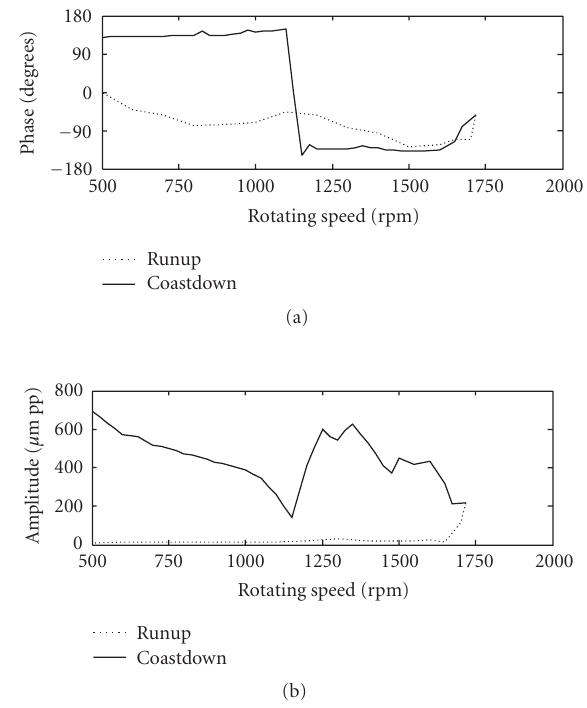
Figure 3: Bode plot of the 1X vibrations measured at bearing no. 1 during the first startup and the subsequent coastdown carried out after the rub occurrence.